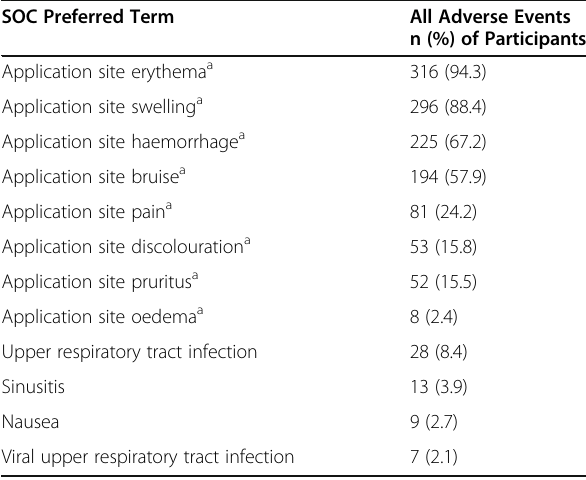
Table 1 Treatment-Emergent Adverse Events (TEAEs) Reported in ≥ 2% of Participants (Safety Population, N = 335 SOC Preferred Term All Adverse Events n (%) of